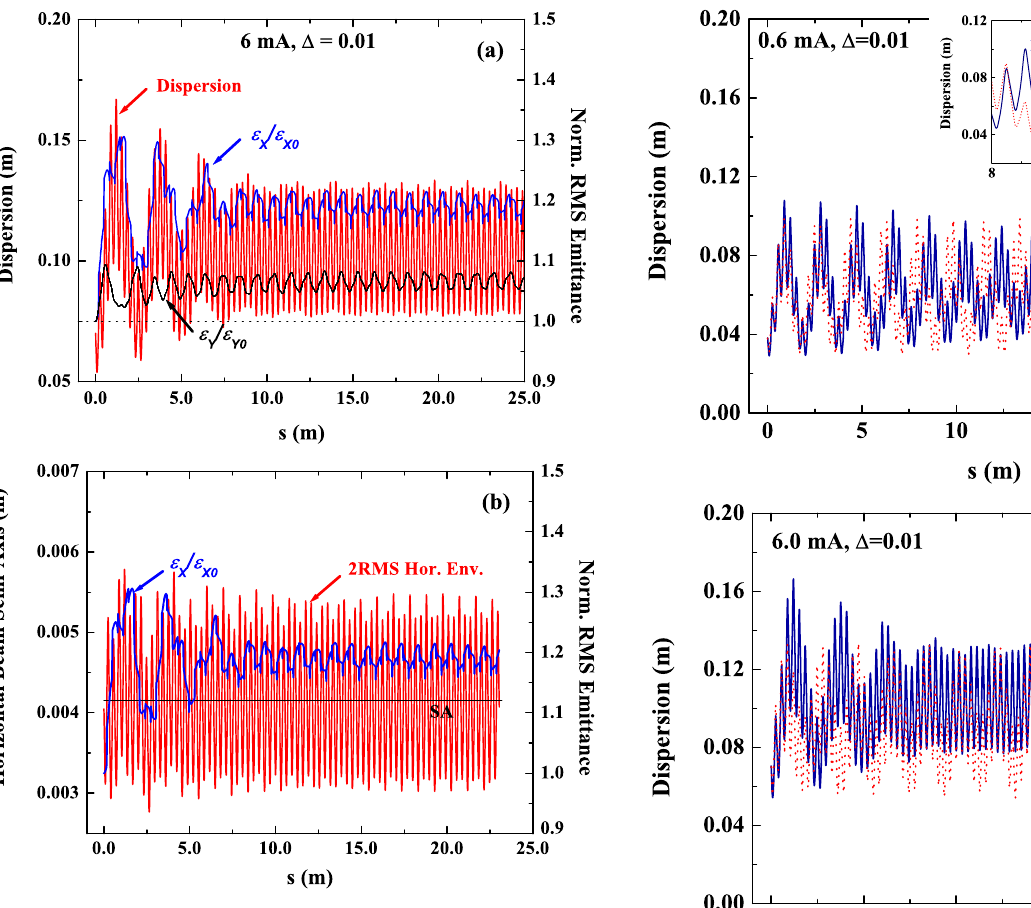
FIG. 5. Evolution of (a) dispersion and (b) horizontal envelope functions (red curves) and standard rms horizontal (blue) and vertical (black) emittances, normalized to initial values, from ELEGANT calculations for 6 mA, (cid:1) ¼ 0 : 01 over two turns in UMER. The initial large oscillations occur even for initial disper- sion/envelope values that are not far from matching conditions.